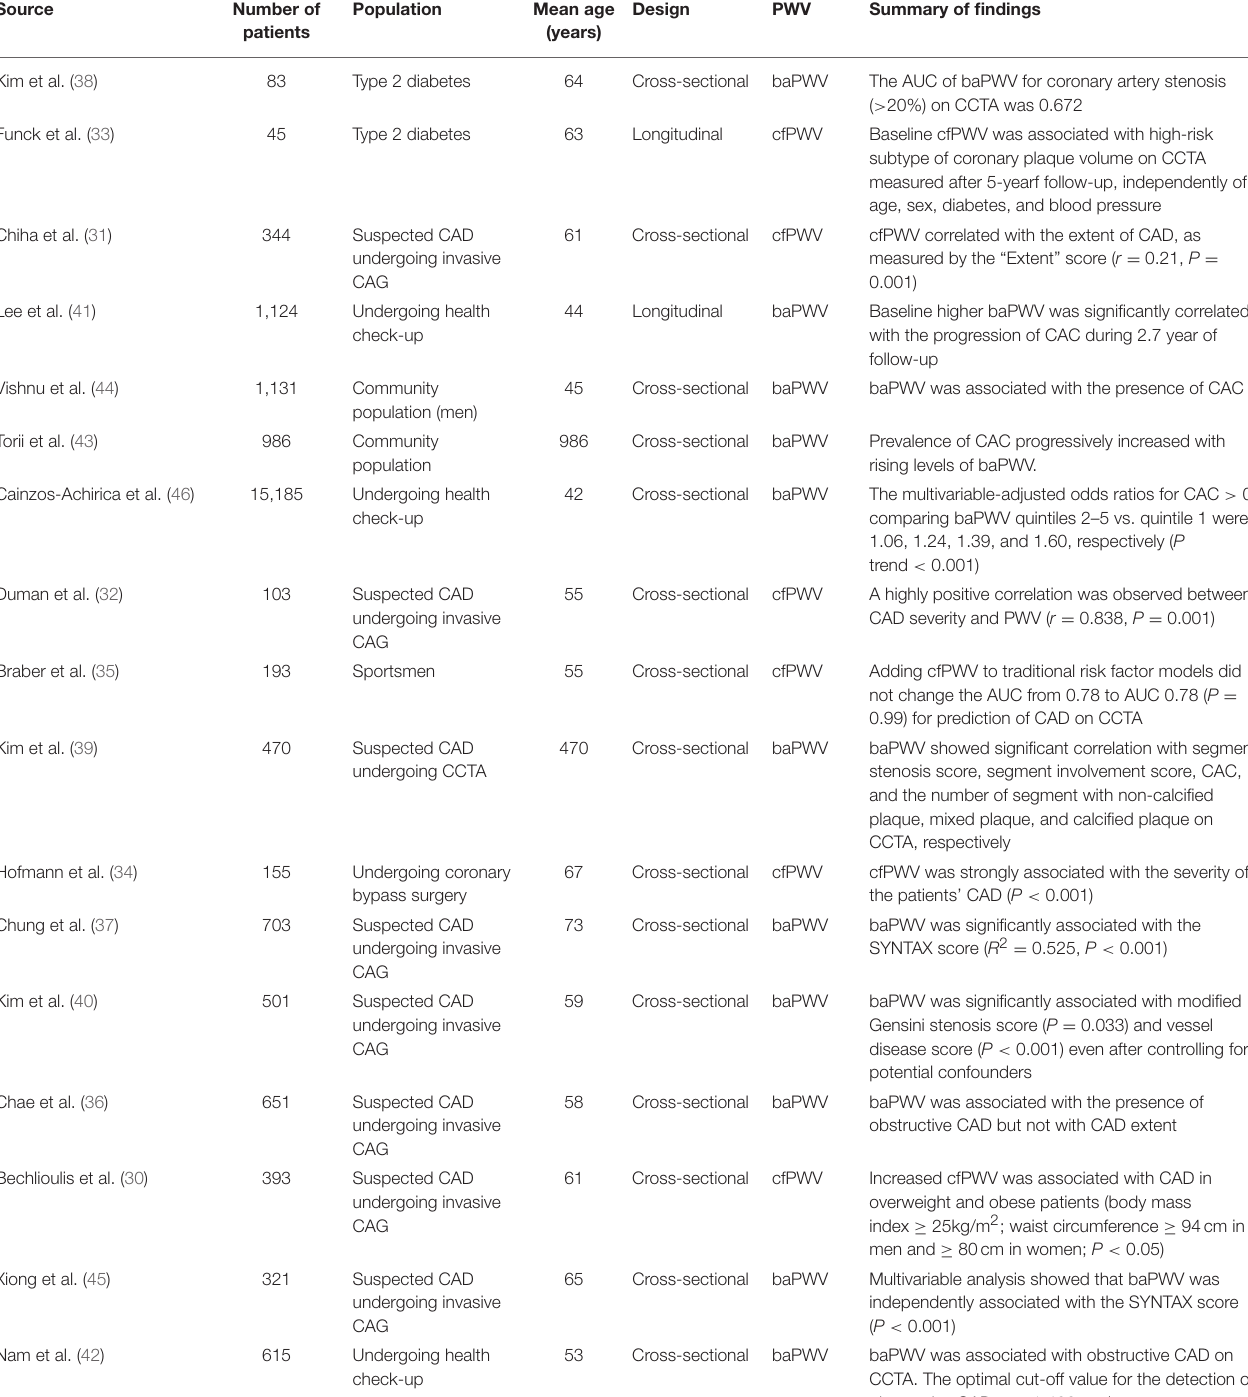
TABLE 1 | Summary of recent studies showing the association between pulse wave velocity and coronary